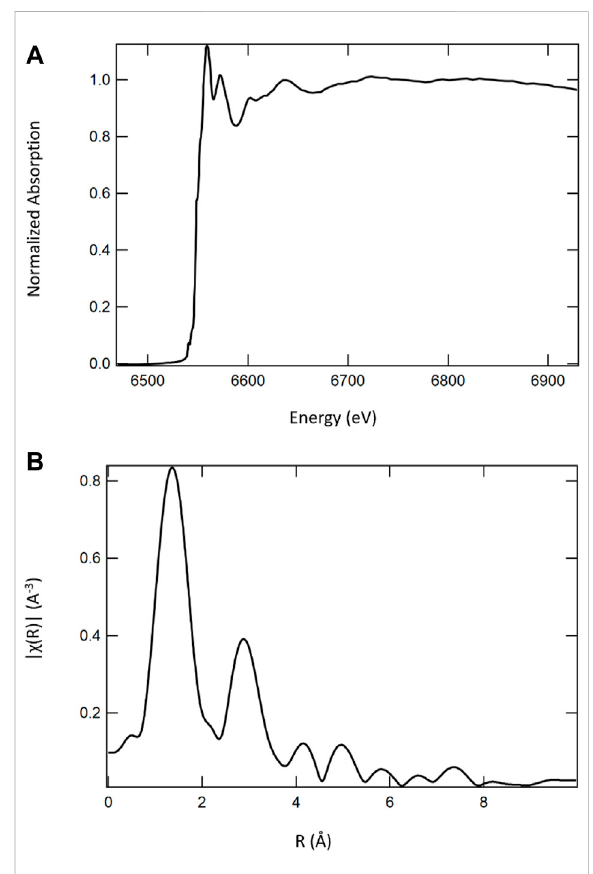
FIGURE 9 Mn K-edge X-ray absorption spectrum (A) of a calcium cerium – manganese oxide STCH material and its corresponding Fourier transform (B) . It is the Fourier transform that would be fi t with the EXAFS equation to determine nearest neighbors, bond distances, and coordination